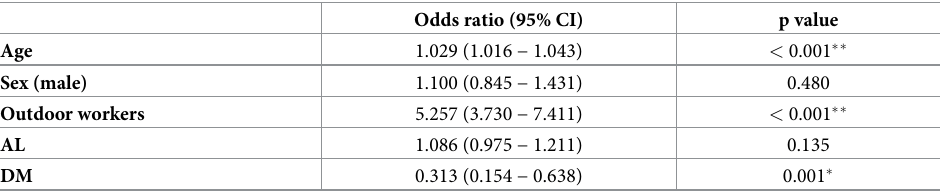
Logistic regression analysis adjusted for age, sex, work history, AL, and DM � p < 0.01 �� p < 0.001. 95% CI, 95% confidence interval for overall prevalence; AL, axial length; DM, diabetes mellitus.